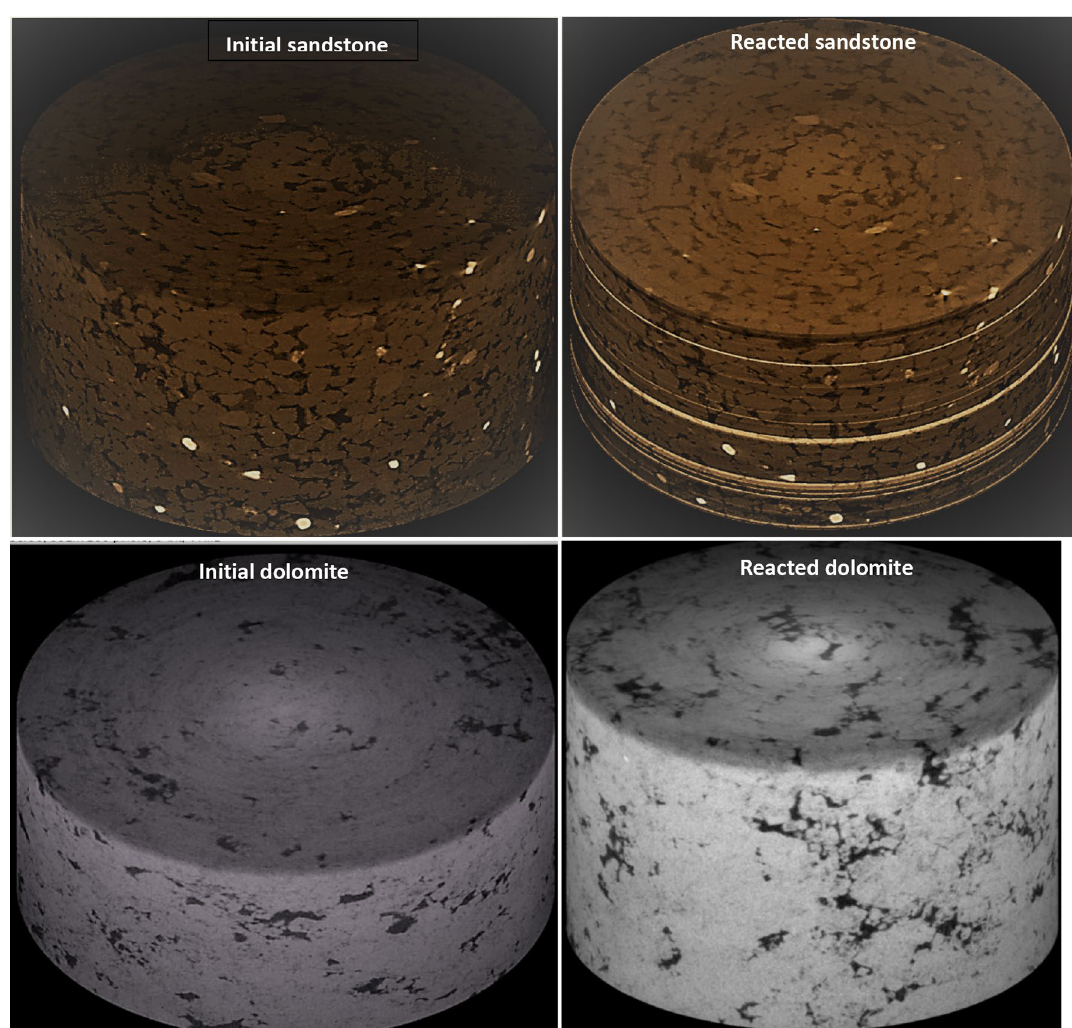
Fig. 11 3D CT scan image of Berea sandstone and Guelph dolomite formation reacted with